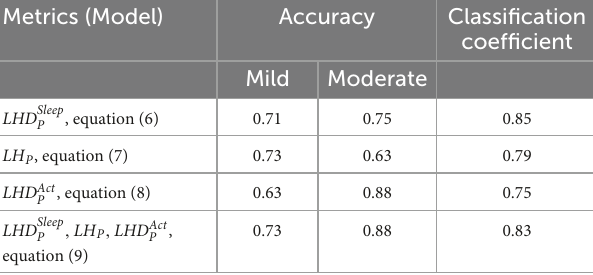
TABLE 5 Classification results for each combination of three HRV